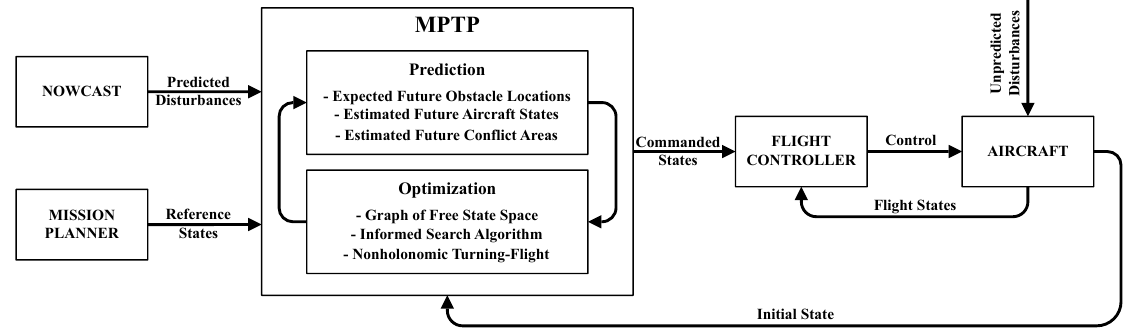
Figure 1. Schematic of the presented MPTP and its environment. The update rate is five